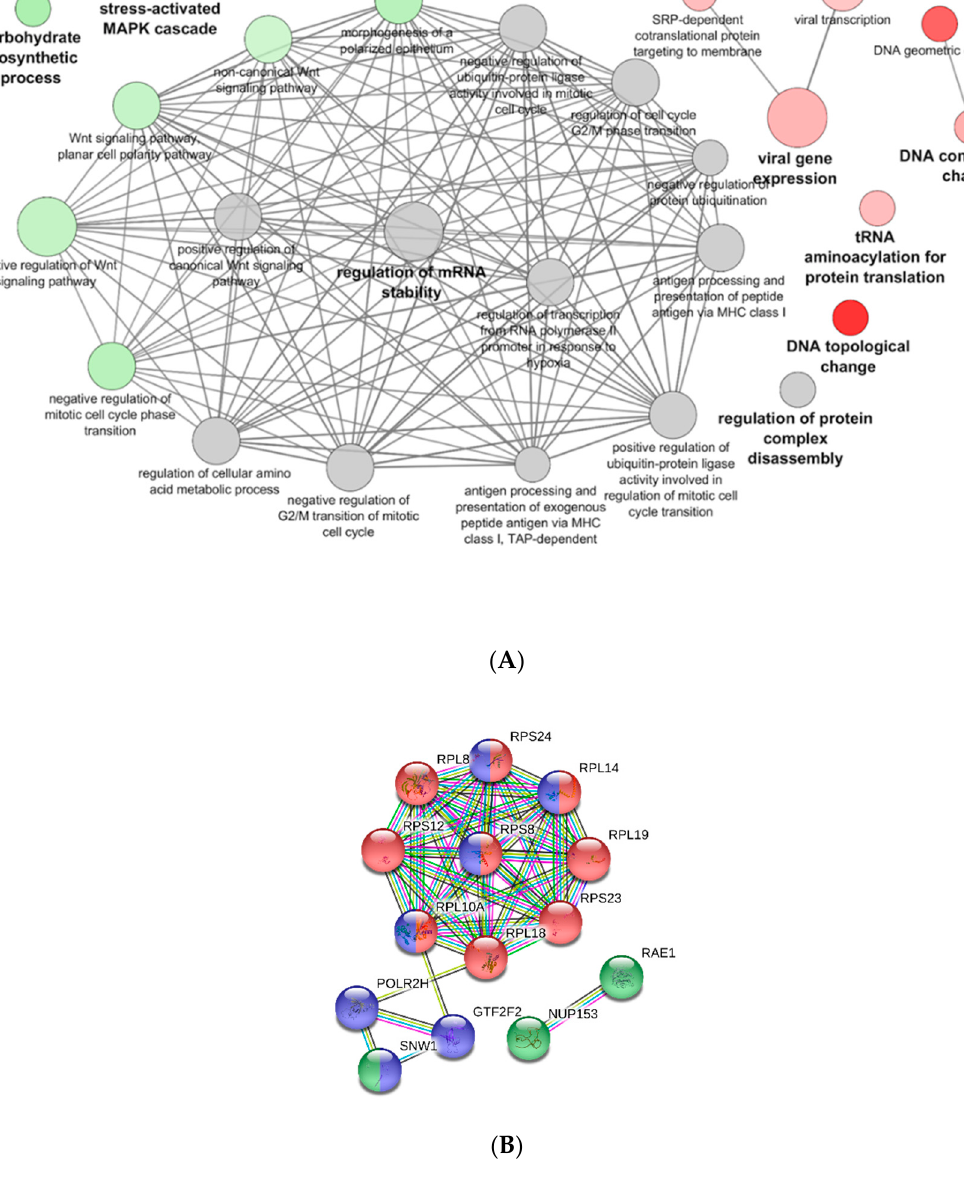
Figure 6. Functional pathway enrichment analysis of DEPs in PB-RBCs from VHSV-challenged individuals. ( A ) A functional pathway enrichment analysis was performed using the GO Immune System Process and GO Biological Process databases with p -value < 0.05, GO Term fusion, and GO Tree interval of 3–8. Red indicates upregulated pathways, green indicates downregulated pathways, and gray indicates nonspecific regulation. ( B ) PPI network of proteins associated with the viral transcription GO Term (GO:0019083) using STRING software ( p -value < 9.99 × 10 − 15 ). Red nodes denote proteins implicated in translation initiation (GO:0006413). Blue nodes denote proteins implicated in RNA processing (GO:0006396). Green nodes denote proteins implicated in viral process (GO:0016032). Nodes represent proteins, while edges denote interactions between two proteins. Di ff erent line colors represent the types of evidence used in predicting the associations: Gene fusion (red), gene neighborhood (green), co-expression (black), gene co-occurrence (blue), experimentally determined (purple), from curated databases (teal), text-mining (yellow), or protein homology